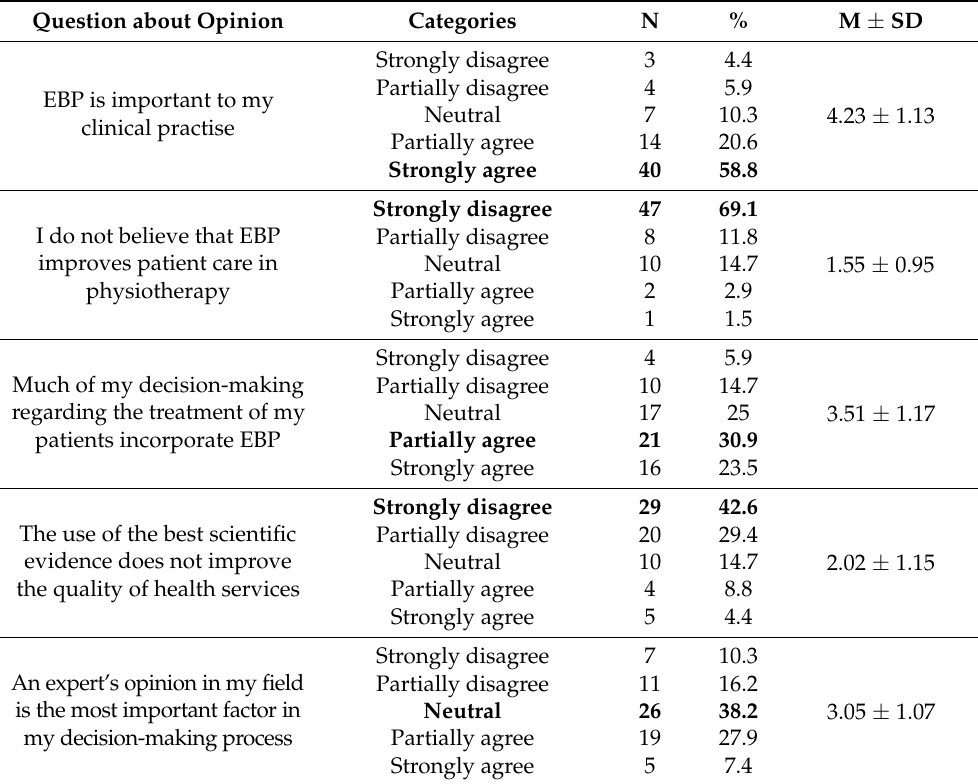
Table 4. Self-reported characteristics related to EBP—opinion.